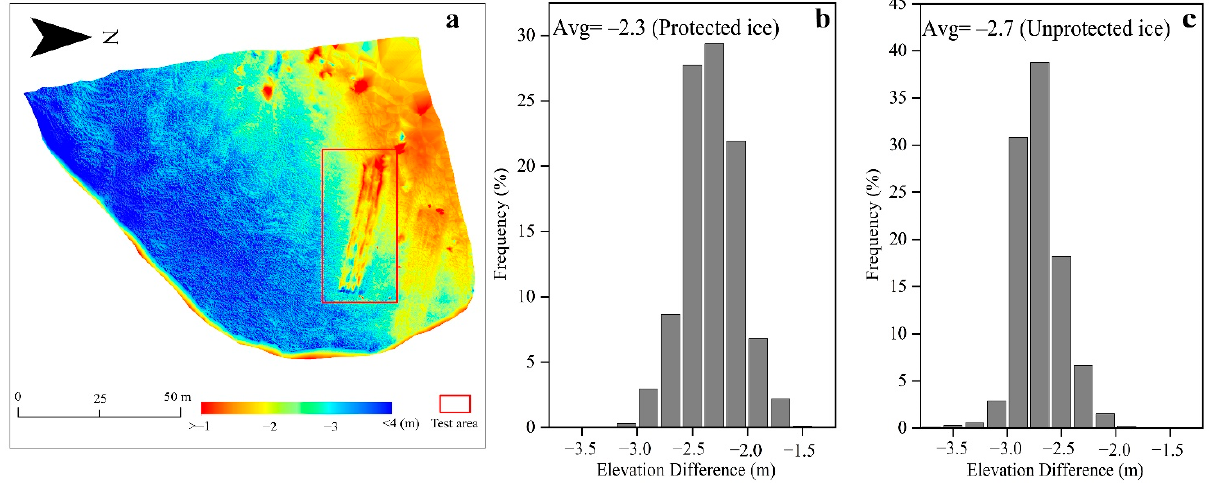
Figure 6. ( a ) The annual surface elevation change statistics after TLS-derived DEM differencing for two consecutive years. ( b , c ) The corresponding frequency distribution (indicated using a red box) in the elevation change between 2020 and 2021.